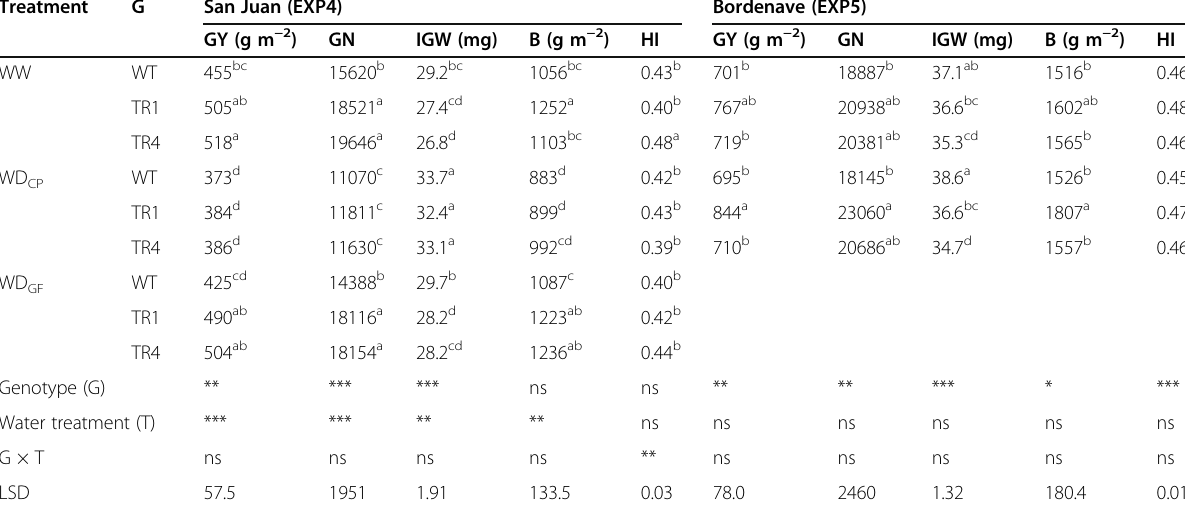
Table 5 Grain yield and its primary and physiological components under field conditions Treatment